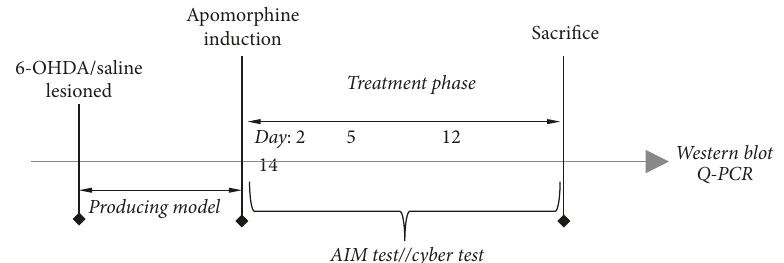
Figure 1: The protocol of the experiment. Dopamine depletion was induced by 6-OHDA injections in the medial forebrain bundle (MFB) while the sham group was injected with salinein the MFB. Threeweeks later, therats that exhibited apomorphine-induced rotations exceeding 7 turns/min in the apomorphine induction test were put to the subsequent experiment. The sham and PD groups were injected with saline once daily; the LID group received L-Dopa (25 mg/kg) and benserazide (6.25mg/kg) cocktail once daily, while the MTEP group received MTEP (5mg/kg) 30 min before the injection of L-Dopa and benserazide. All treatments were performed for 14 days; behavior tests like AIM test, open field test, and cylinder test were performed on days 2, 5, 12, and 14. Two hours after the last injection on the 14th day, all groups were sacrificed for western blot and